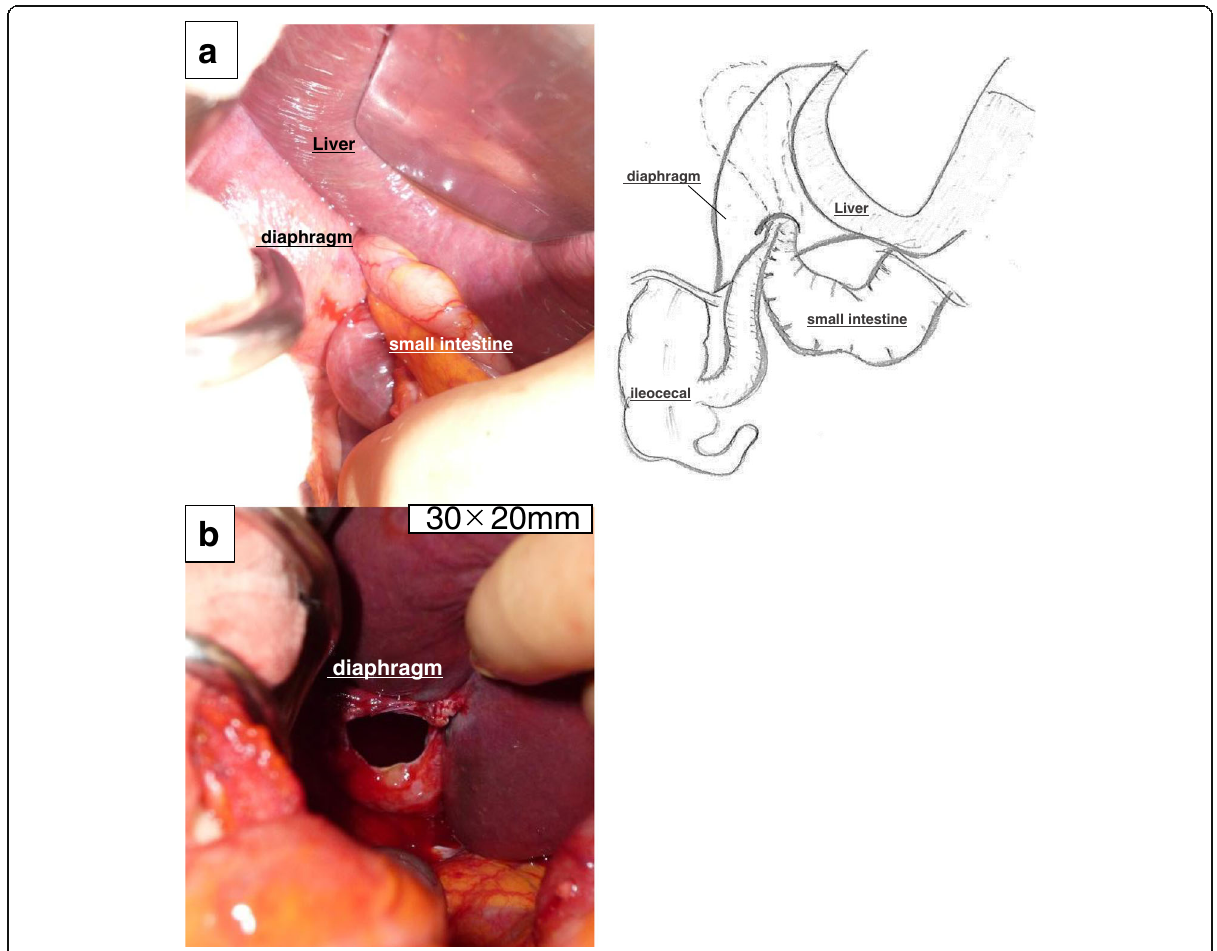
Fig. 2 Surgical approach to repair of the right-sided Bochdalek hernia. a Presence of an oval hernia orifice with a diameter of 3 cm in the right posterior surface of the diaphragm. b The small intestine was reduced back into the abdominal cavity from the right thoracic cavity, demonstrating the diaphragmatic hernia